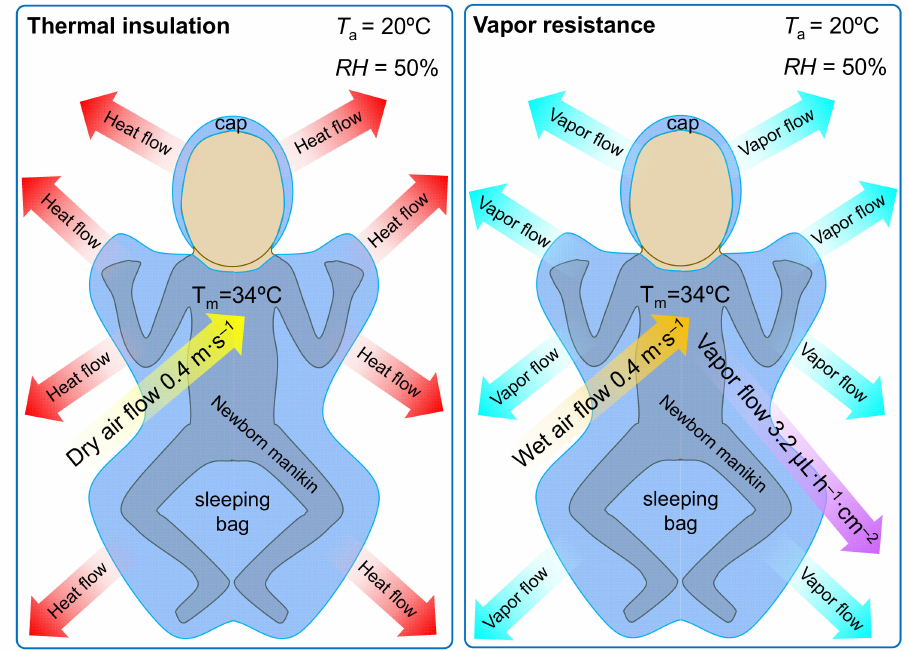
Figure 5. Manikin conditions for thermal insulation and vapor resistance clothing